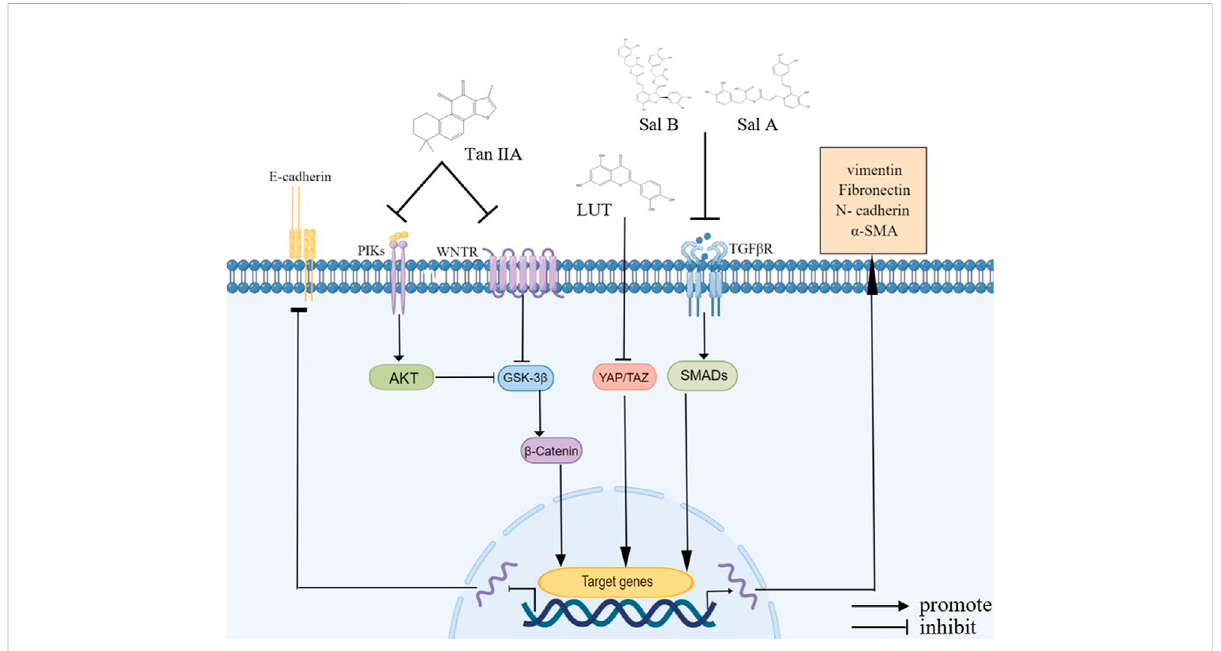
FIGURE 2 Bioactive compounds of S. miltiorrhiza involved in EMT regulation. Tan IIA, LUT, Sal A, and Sal B modulate various signaling pathways, including theNF- κ Bsignaling pathway,VEGFsignaling pathway, β -cateninsignaling pathway,andPI3K/Aktsignaling pathway,andtheyupregulateE-cadherin and downregulate N-cadherin, α -SMA, vimentin, and fi